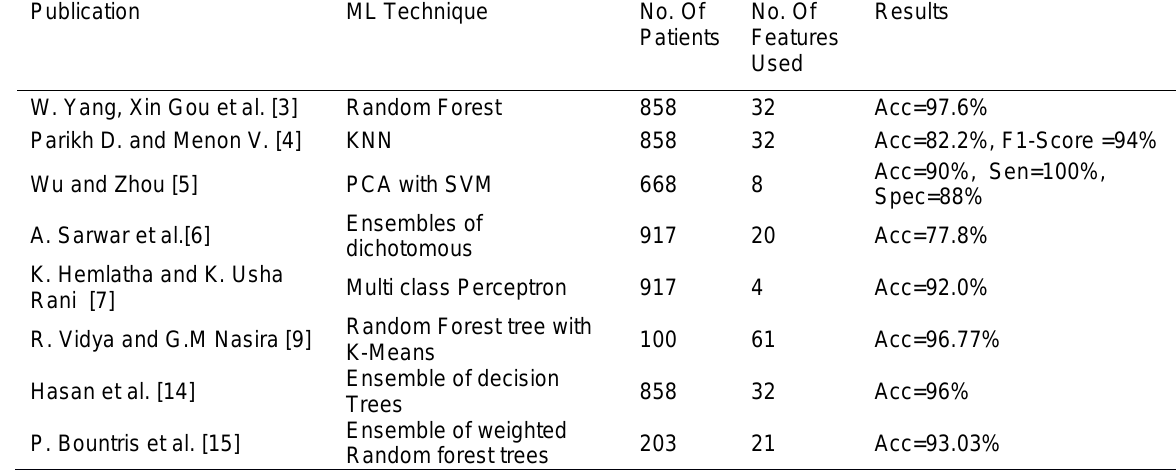
Table 1. Publication relevant to ML methods used in Cervical Cancer